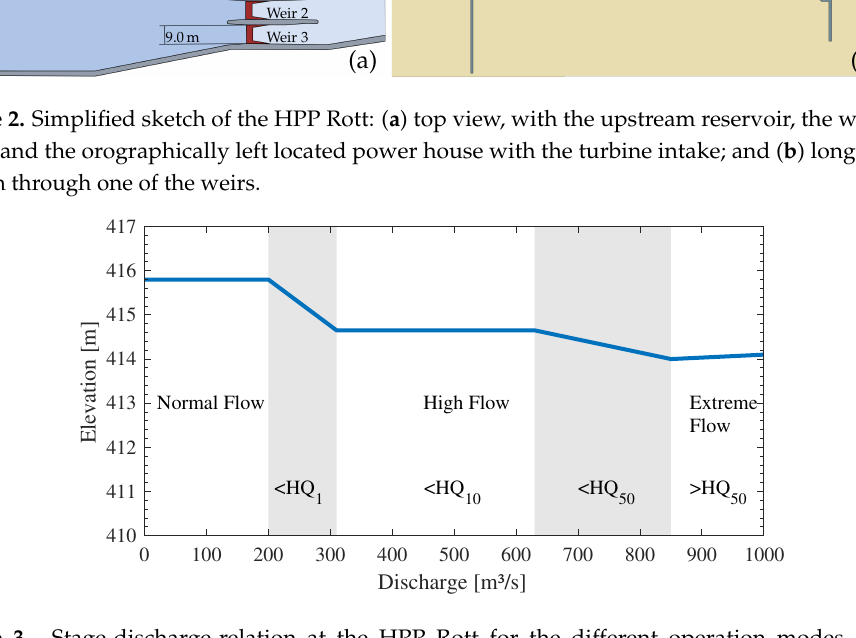
Figure 3. Stage-discharge-relation at the HPP Rott for the different operation modes and the transition